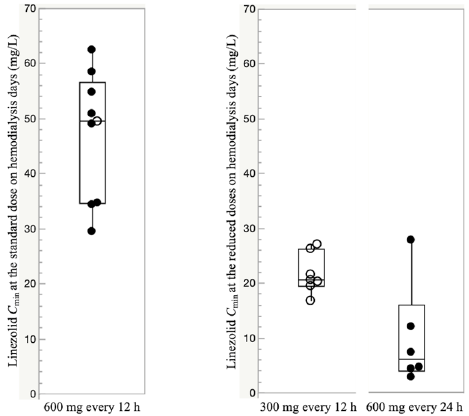
Figure 2. Boxplots of trough concentration (C min ) at the standard dose and the reduced doses to 300 mg every 12 h and 600 mg every 24 h on hemodialysis days. For each boxplot, the horizontal line across the box represents the median, each box represents the range between the 25th and 75th percentiles, the two whiskers represent the minimum and maximum values within 1.5 × IQR, and points beyond the whiskers represent outliers. Closed circles represent C min administered through the intravenous route, and open circles represent C min administered through the oral